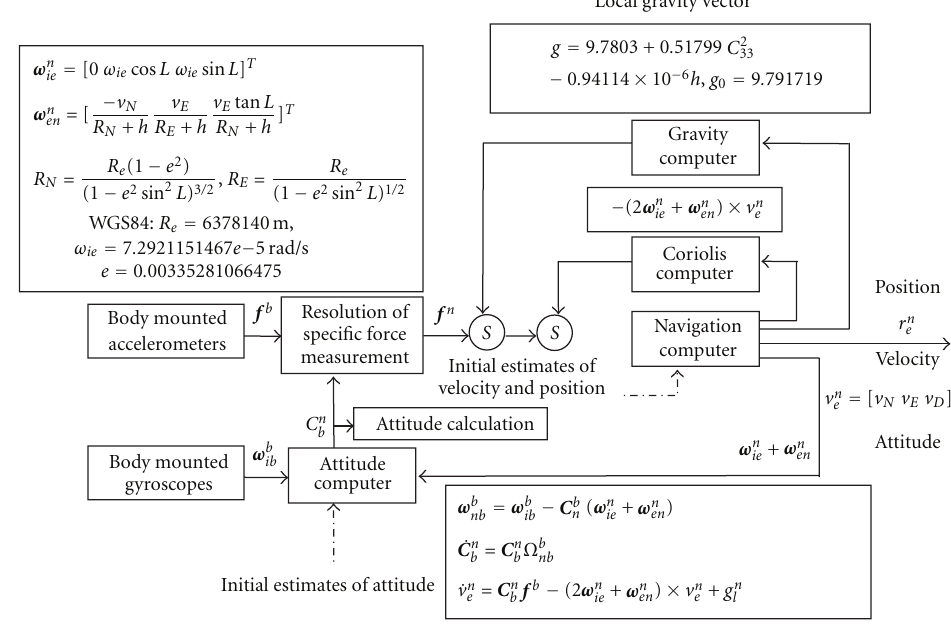
Figure 6: SINS ENU -frame